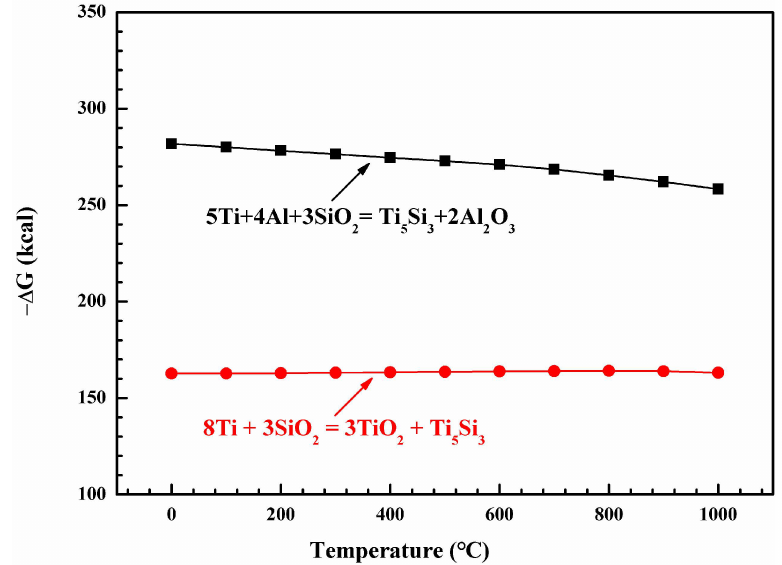
Figure 9. Standard Gibbs free energy changes ( ∆ G θ ) of forming Ti 5 Si 3 as a function of temperature (standardized to forming 1 mol Ti 5 Si 3